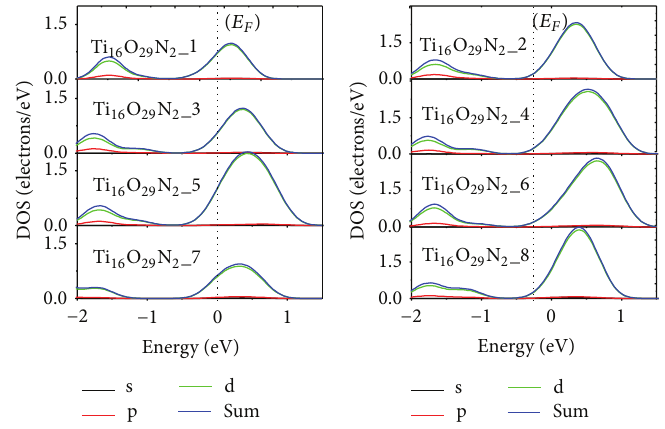
Figure 10: The DOS of Ti atom of eight kinds.